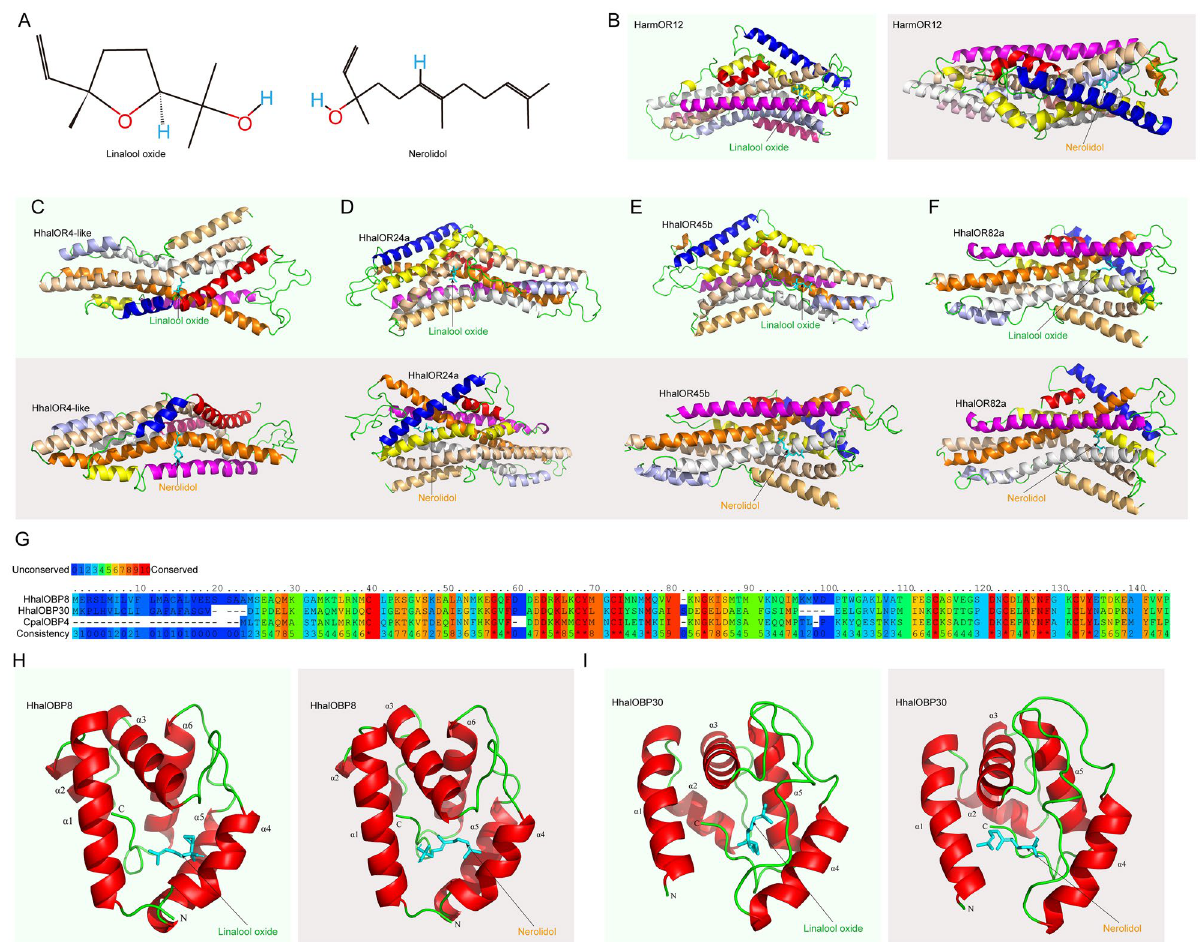
Figure 3. Molecular docking studies of H. halys olfactory proteins to linalool oxide and nerolidol. ( A ) Chemical structures of linalool oxide (left) and nerolidol (right). ( B ) Schematics showing docking poses of HarmOR12 binding with linalool oxide (left) and nerolidol (right), respectively. ( C–F ) Schematics showing docking poses of HhalOR4-like (C), HhalOR24a (D), HhalOR45b (E), and HhalOR82a (F) binding with linalool oxide (up) and nerolidol (down), respectively. ( G ) Sequence alignment between HhalOBP8, HhalOBP30, and CpalOBP4 ( Chrysopa pallens OBP4: 6jpm.1.A). Conservations of amino acid residues were indicated with colors. Identities of HhalOBP8 with CpalOBP4 was 36.97%, and for HhalOBP30 and CpalOBP4 it was 33.04%. ( H–I ) Schematics showing docking poses of HhalOBP8 (H) and HhalOBP30 (I) binding with linalool oxide (left) and nerolidol (right),